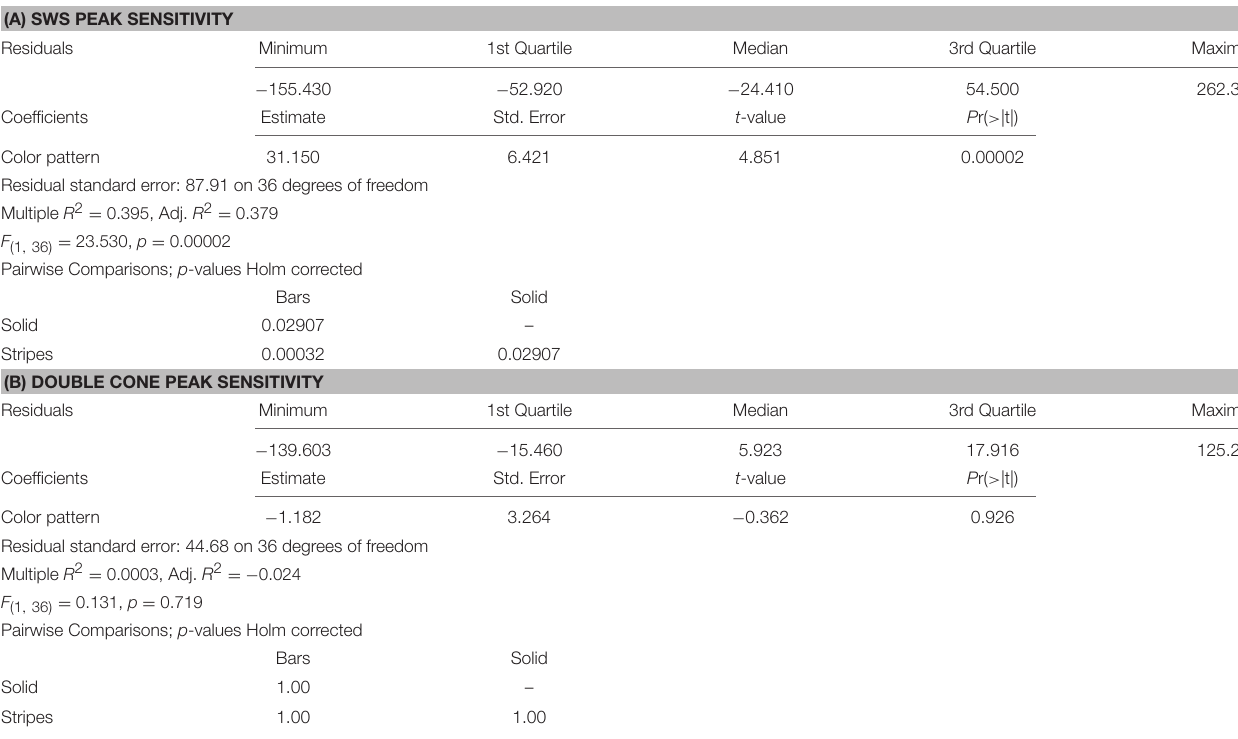
TABLE 2 | Phylogenetic Independent Contrast between opsin peak sensitivity and color